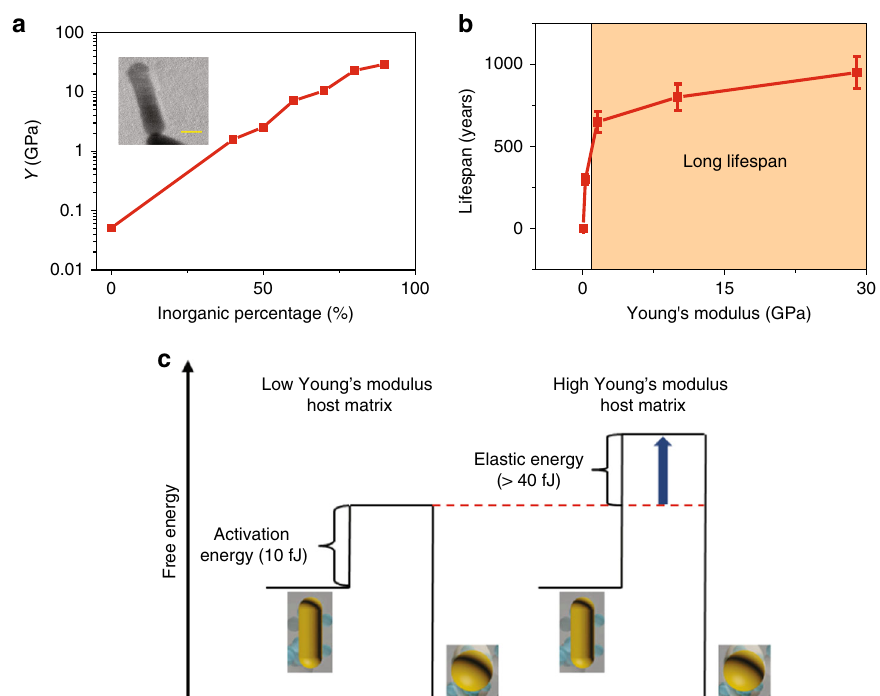
Fig. 2 Long lifespan of optical data memory in nanoplasmonic hybrid glass composites. a Young ’ s moduli ( Y ) of the nanoplasmonic hybrid glass with different inorganic percentages. Inset: Transmission electron microscope image of the nanoplasmonic hybrid glass composites. b Lifespan of the gold nanorods in the nanoplasmonic hybrid glass composites with different Young ’ s moduli. Standard deviations are represented by error bars. c Simpli fi ed effective energy barrier model of the data memory with gold